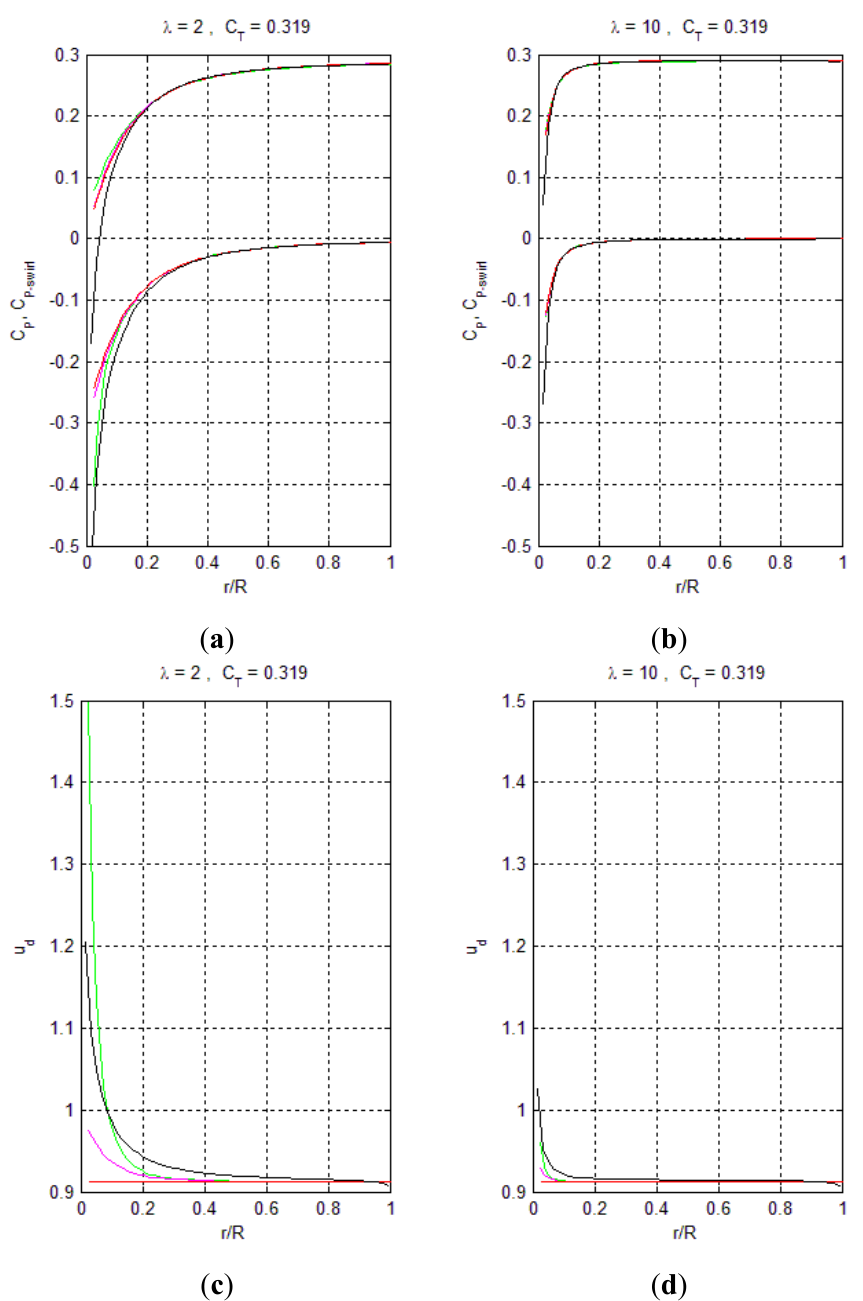
Figure 9. BEM (colored) and AD (black) spanwise distribution of power (upper) and mass-flow (lower) at low thrust loading, (cid:1829) (cid:3404) 0.319 for a regular HAWT. ( a , c ) TSR = 2; ( b , d ) TSR = 10. (cid:2904) The general trend for the AD model to predict higher mass-flow over a broad range spanning the mid part of the “disk blades” is not captured by any BEM method, and hence attributable to the streamline deflection and wake